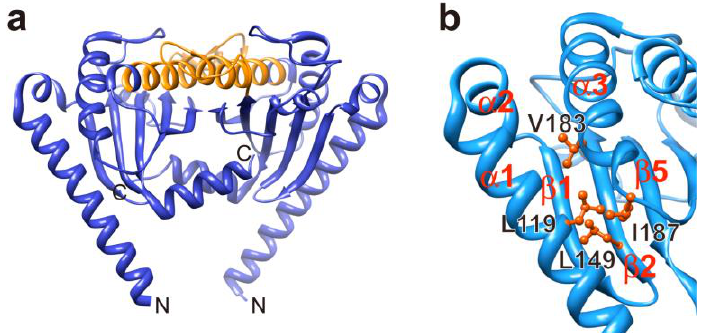
Figure 5. The crystal structure of MotB from Salmonella . (a) Cα ribbon representation of C Salmonella MotB dimer in the crystal (PDB ID: 2ZVY). The peptidoglycan binding C (PGB) motif is shown by orange. (b) The MotB structure in the vicinity of Leu119. C Leu119 in helix α1 shows hydrophobic interactions with Leu149 in strand β2 and Val183 and Ile187 after helix α3.